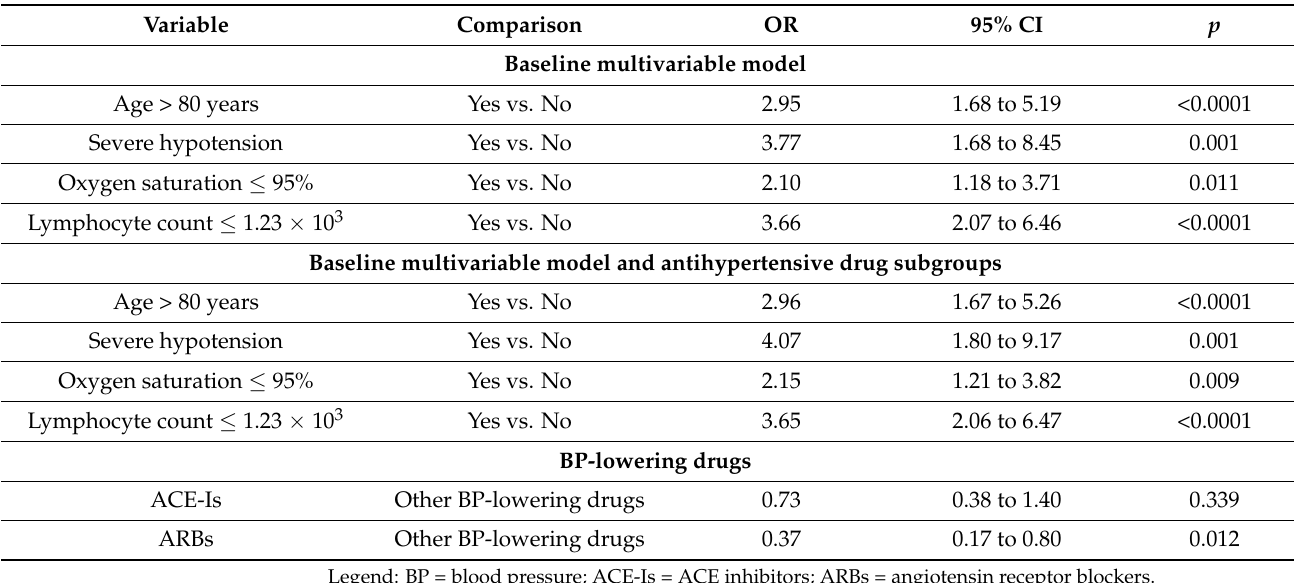
Table 2. Multivariable model exploring the impact of ACE inhibitors and angiotensin receptor blockers on the risk of in-hospital death (lower panel) when added to a baseline multivariable model identified according to information criteria (upper panel).